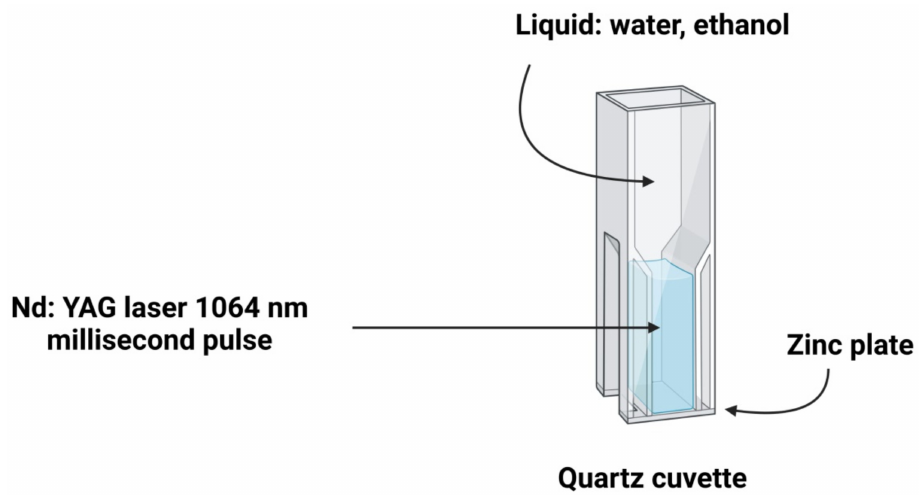
Figure 7. Diagrammatic representation of the stages required for metallic NPs synthesis (for example ZnO-NPs) employing laser ablation.